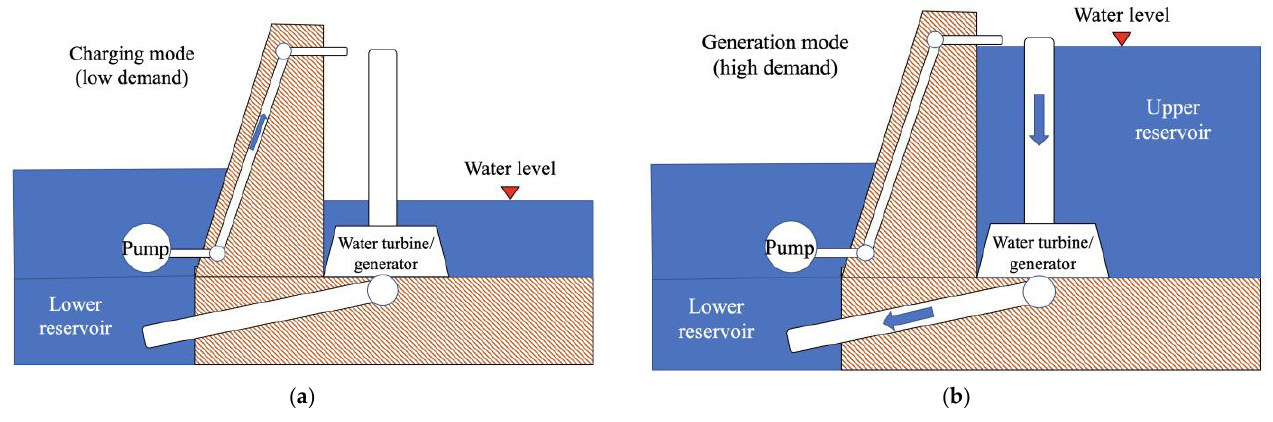
Figure 4. Operation of PHS system in ( a ) charge and ( b ) discharge.